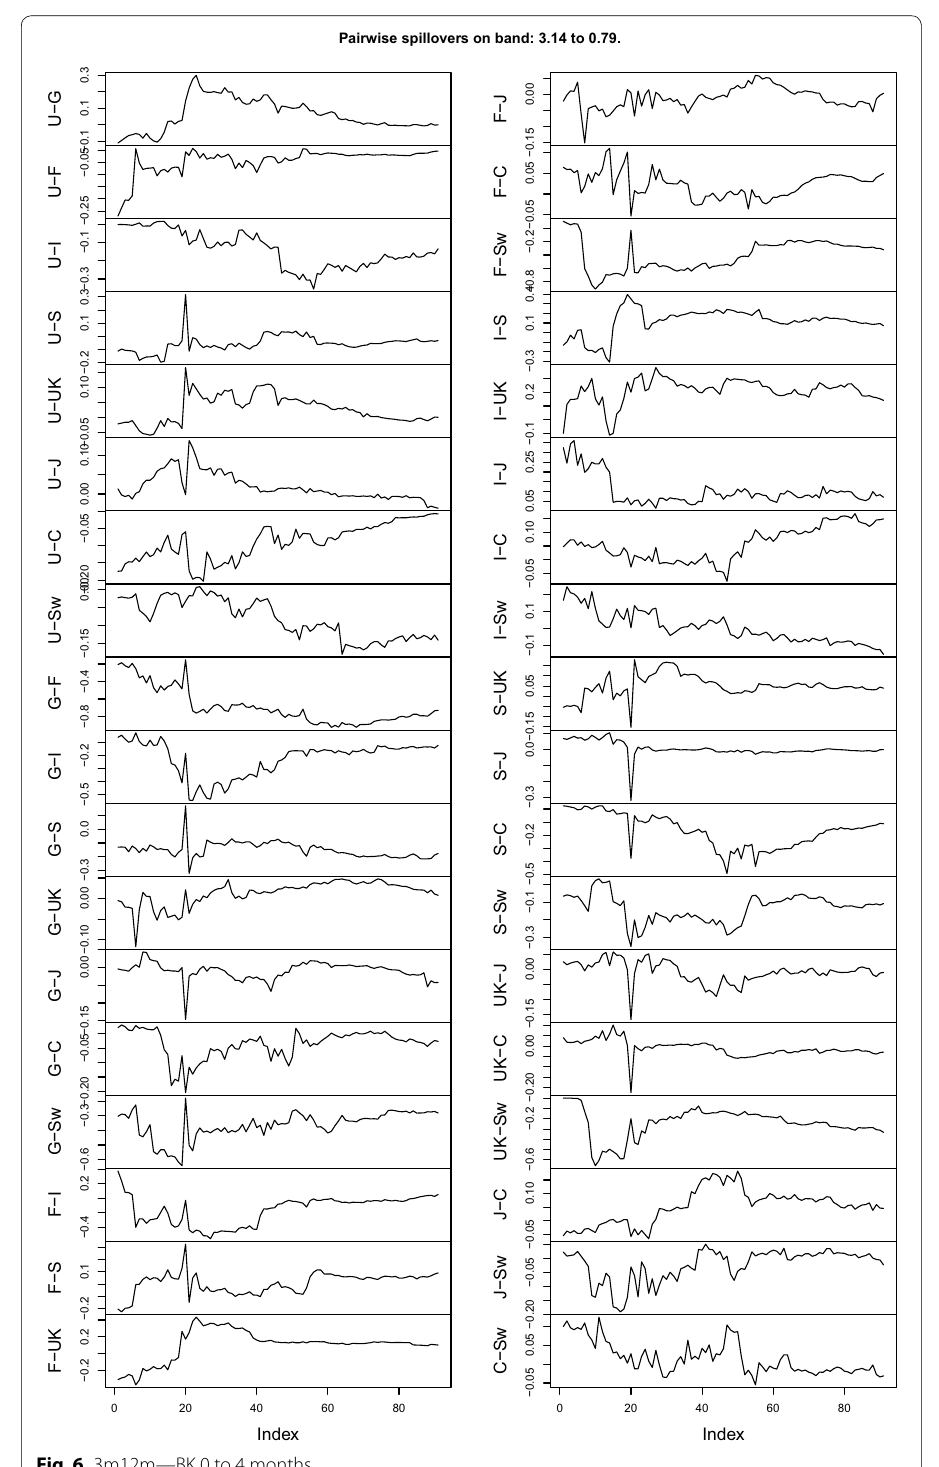
Fig. 6 3m12m—BK 0 to 4